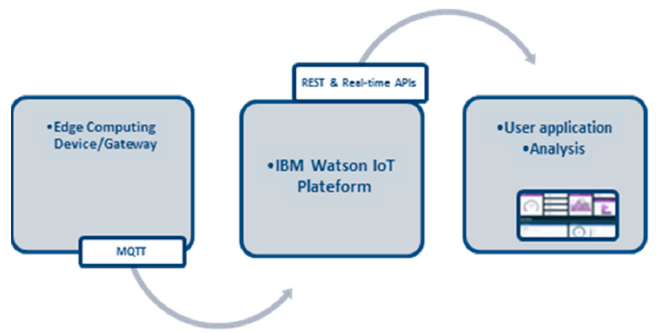
Figure 7. System software architecture.